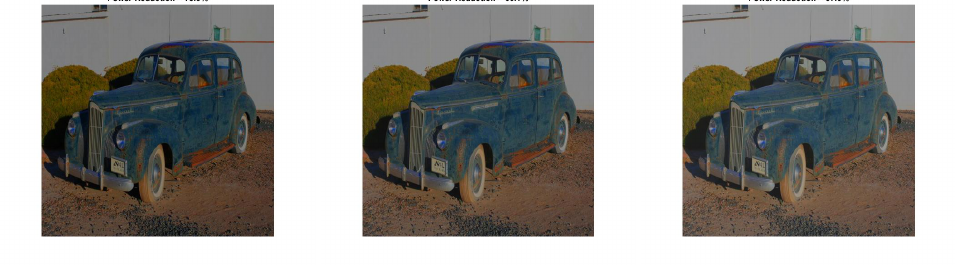
Figure 10. Baboon resulted image I new using Y CBCS (without HE) for a = 0.7 and b = [10:10:30].